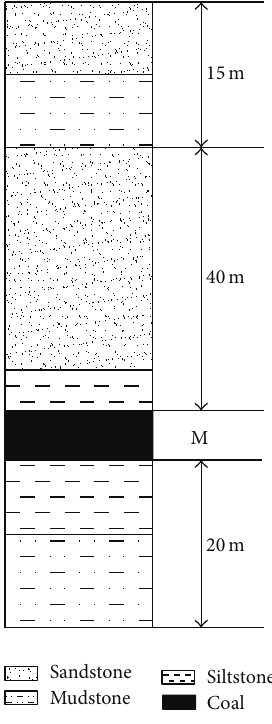
Figure 5: Rock strata